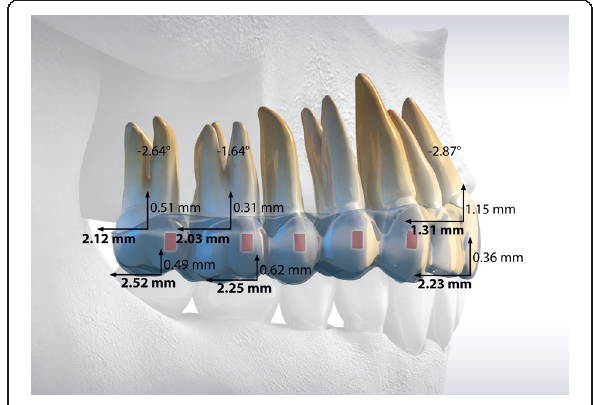
Fig. 4 Schematic illustration of clinically relevant results for the study